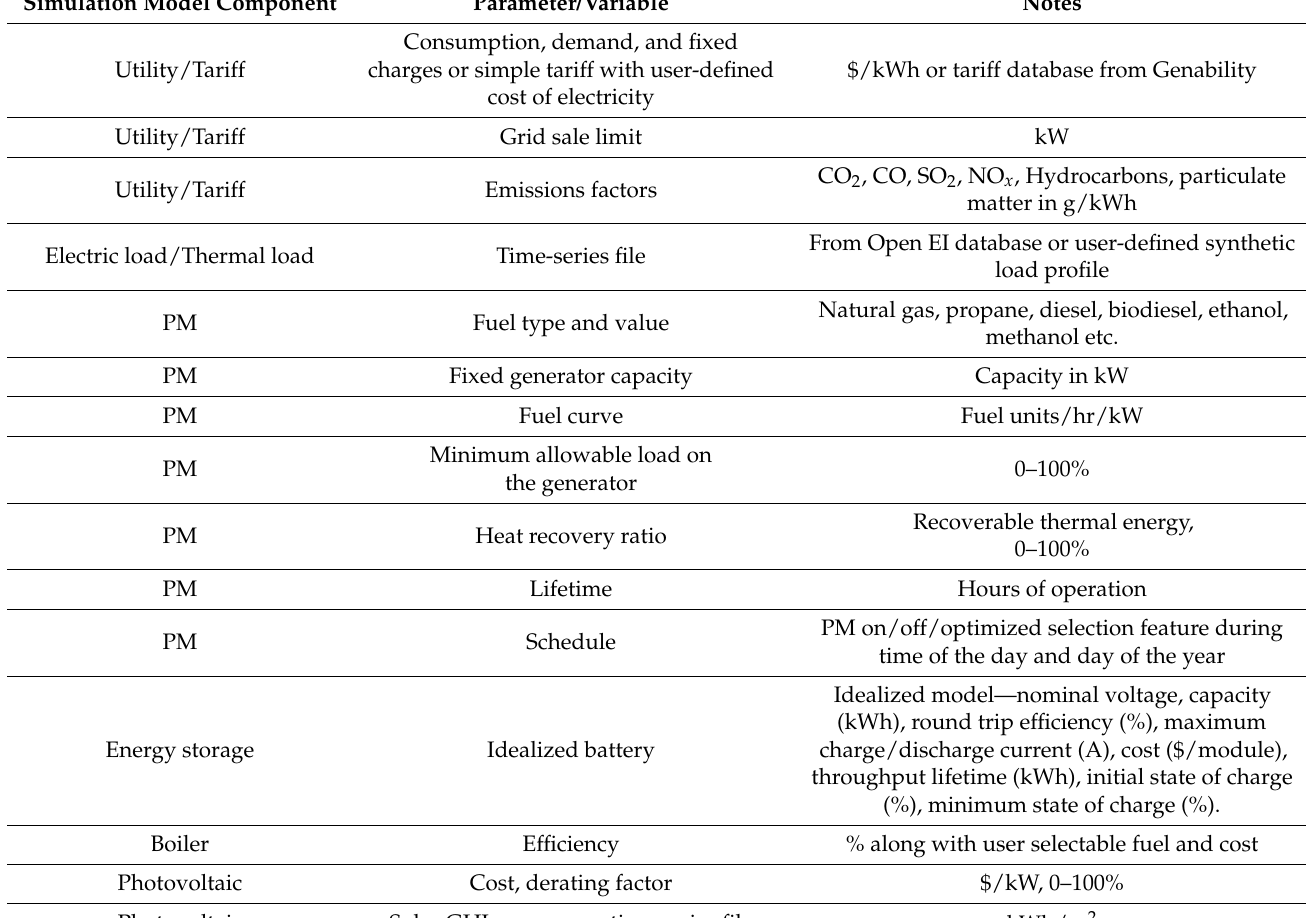
Table 1. Simulation model’s components and their primary operating parameters and constraints. Simulation Model